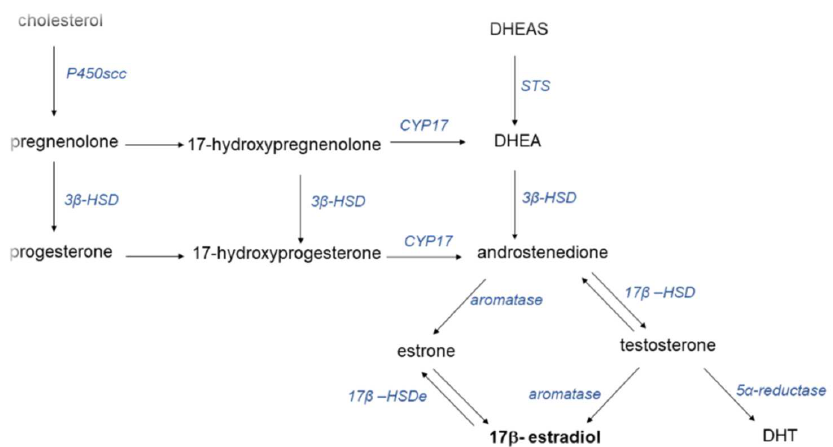
Figure 1. Synthesis of sex hormones. Abbreviations: 3 β : hydroxysteroid dehydrogenase; 17 β : hydroxysteroid dehydrogenase type 1; CYP17: 17a-hydroxylase; DHT: 5 α -dihydrotestosterone; DHEA: dehydroepiandrosterone; DHEAS: dehydroepiandrosterone sulfate; P450scc: cytochrome P450 side-chain cleavage enzyme; STS: steroid sulfatase.